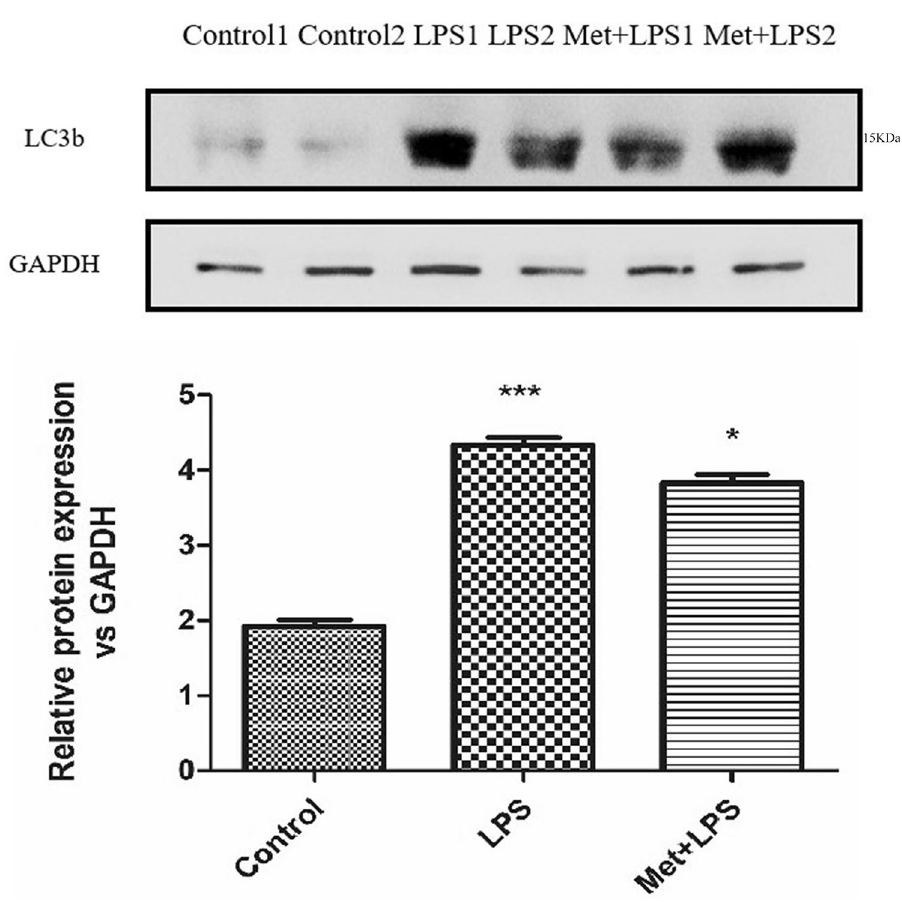
Figure 9. The expression levels of autophagy-related protein LC3b in macrophages in mice treated with lipopolysaccharide and metformin. GAPDH: glyceraldehyde-3-phosphate dehydrogenase, LPS: lipopolysaccharide, Met: Metformin, LC3b: microtubule associated protein 1 light chain 3 beta. LPS group: compared with blank control group. Met + LPS group: compared with LPS group. * P < 0.05, ** P < 0.01, *** P <